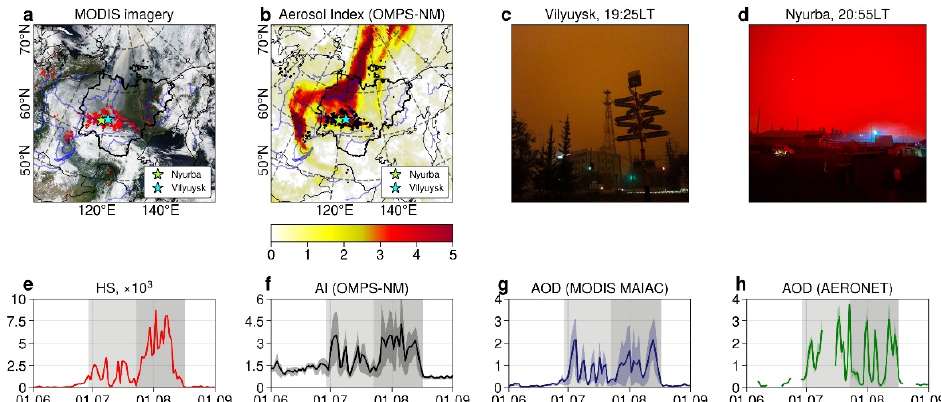
Figure 6. Aerosol pollution episode on 2 August. ( a ) MODIS imagery; ( b , f ) aerosol index; ( c , d ) pictures of the sky taken at the towns of Vilyuysk and Nyurba at approximately 19:25 LT and 20:55 LT; ( e ) MODIS hotspots; ( g ) AOD at 550 nm from MODIS MAIAC algorithm; ( h ) AOD at 500 nm from AERONET sun photometer at Yakutsk. Red ( a ) and black ( b ) dots are MODIS HS. Star symbols ( a , b ) indicate the locations of the settlements. Grey vertical bars indicate two periods of wildfire activity. Line plots ( e – h ) refer to the study region. Shaded areas on figures ( f – h ) indicate a 25–75 percentile range.